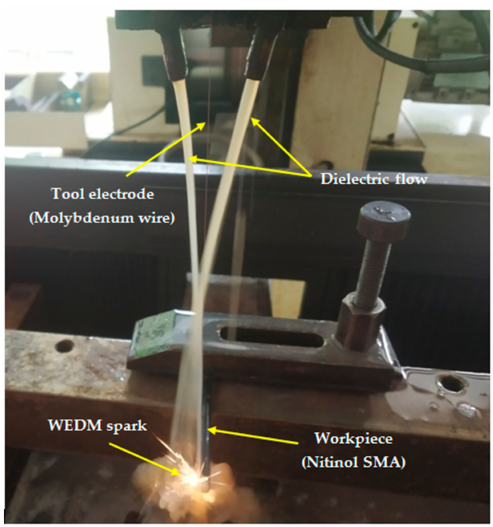
Figure 2. Flushing mechanism for the wire electrical discharge machining (WEDM) process.